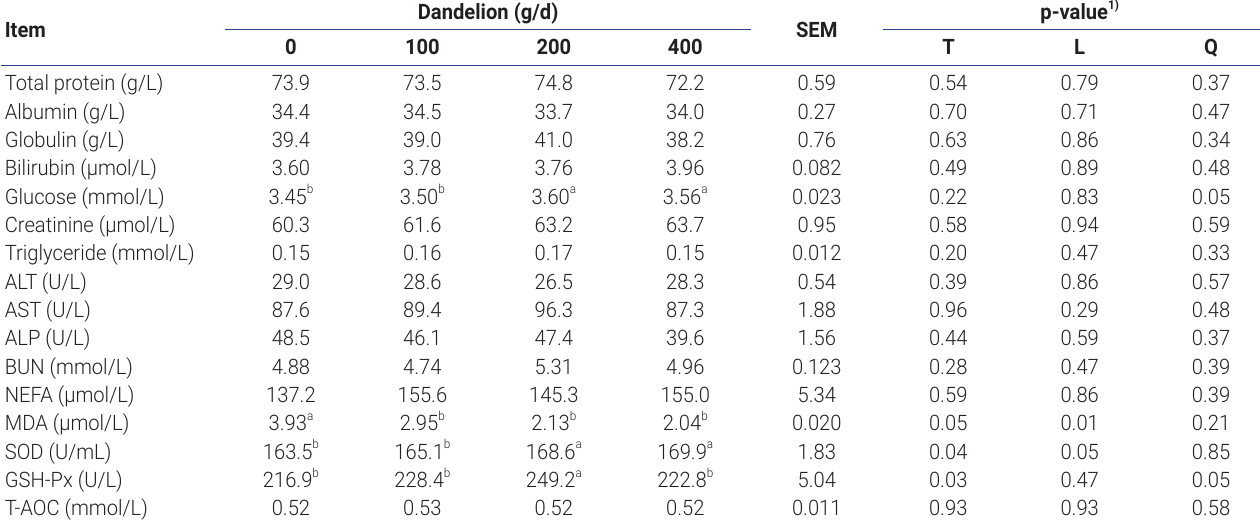
Table 2. Effects of dietary dandelion supplements on plasma variables in primiparous dairy cows Dandelion (g/d) Item